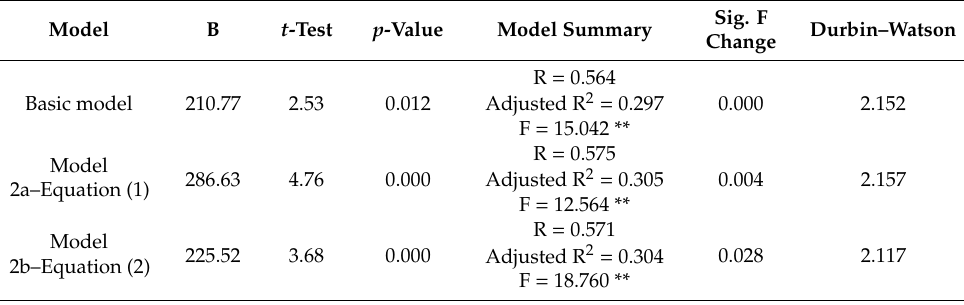
Table 4. Values of statistical and econometric tests.